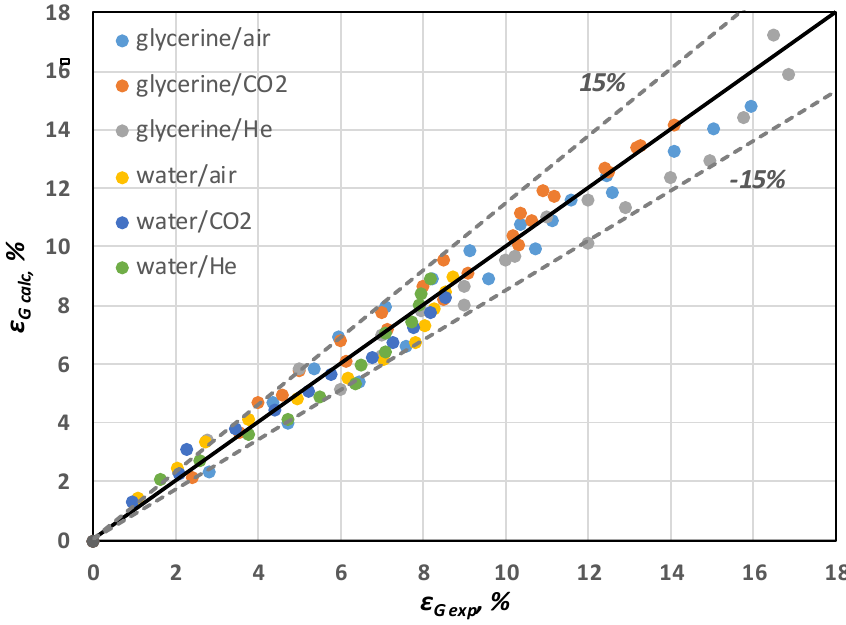
Figure 8. Comparison of the proposed correlation with the experimental data.